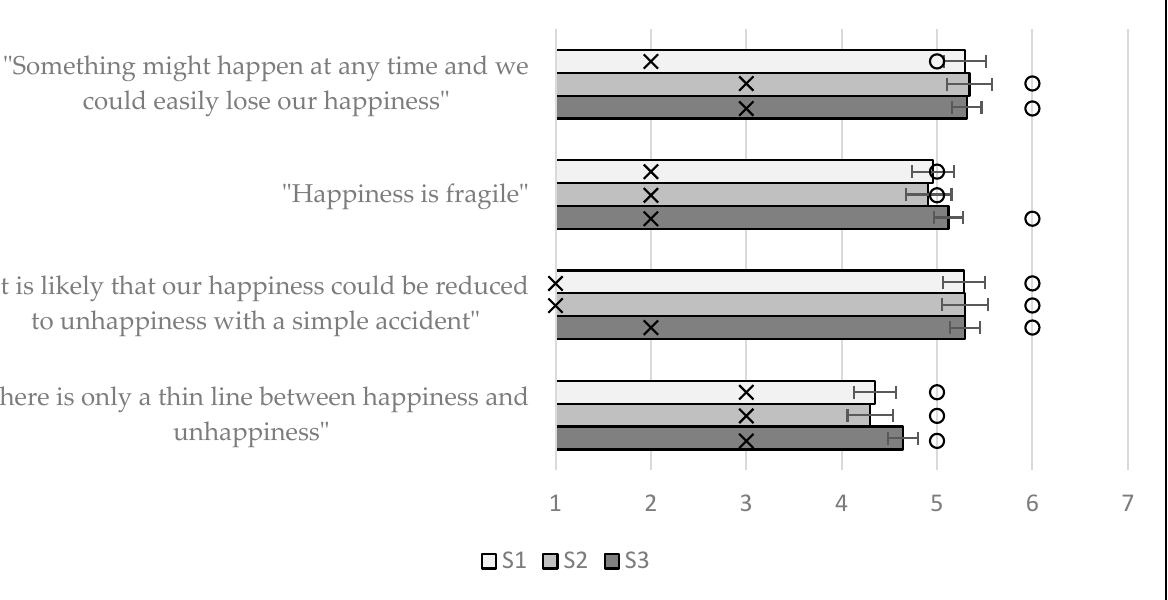
Figure 3. Means and standard error bars for the individual items of the FOHS; the IQR is represented by an ‘x’ and the median by a circle.